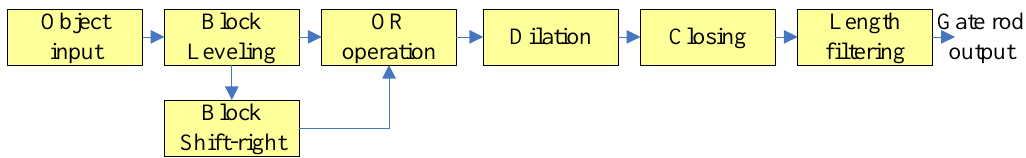
Figure 7. The flow chart of the railway crossing gates extraction.